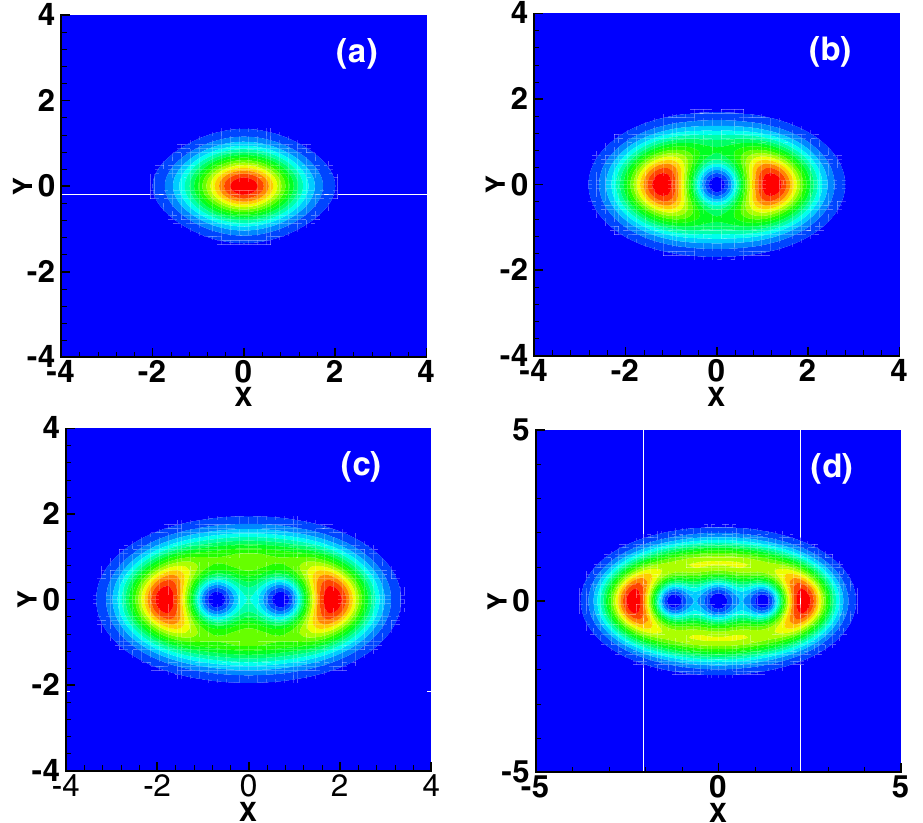
Figure 1. Profiles of lowest order spiraling elliptic Hermite-Gaussian beam. ( a ) Fundamental mode with n = 0; ( b ) first-order mode with n = 1; ( c ) second-order mode with n = 2; ( d ) third-order mode with n = 3. The parameters of all figures are b = 1.2 and c = 0.8 in Eq. (3).